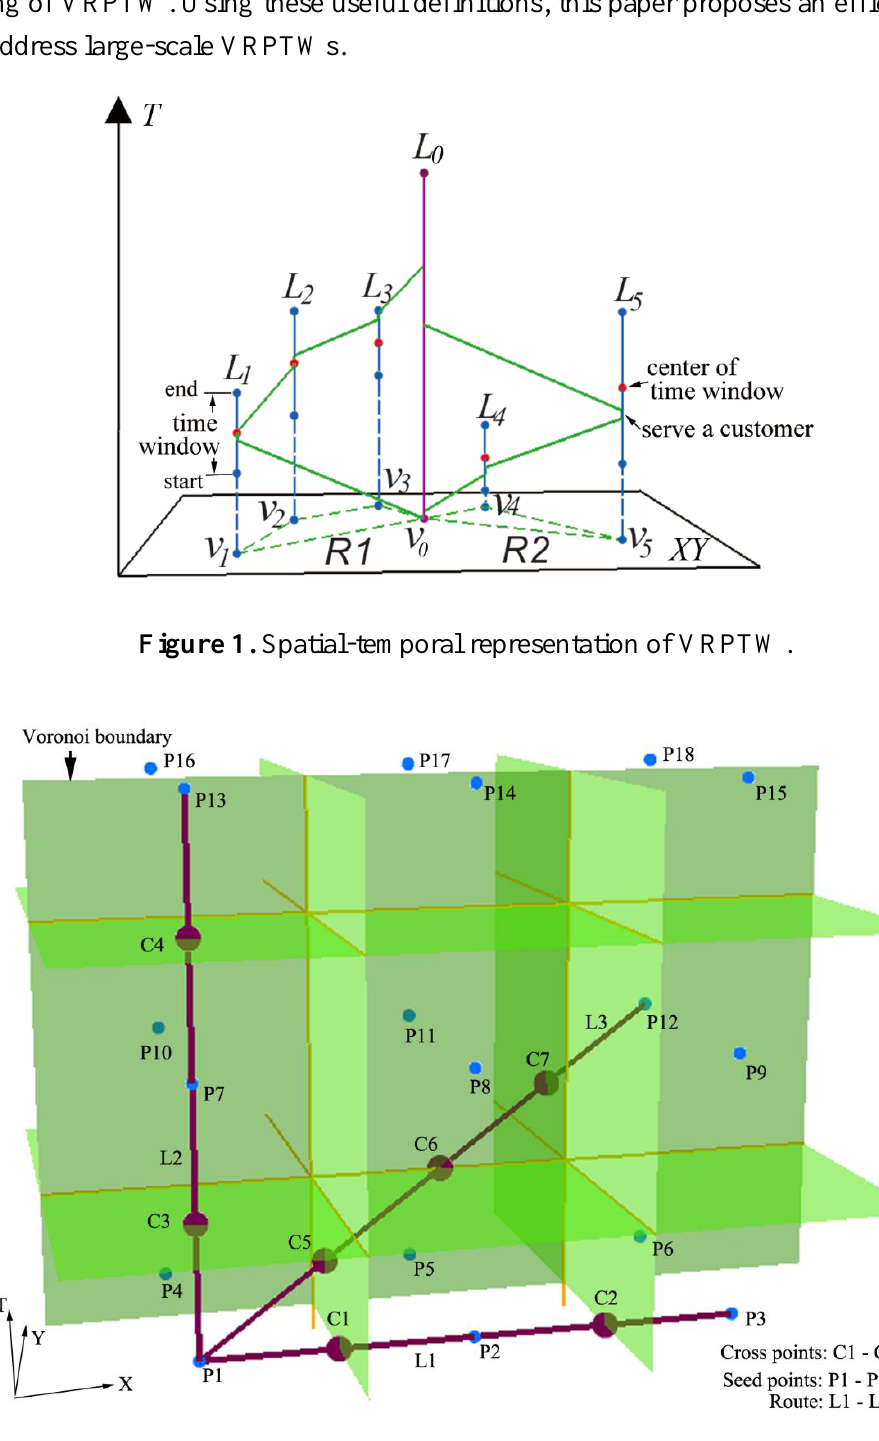
Figure 2. The spatial-temporal Voronoi diagram and the spatial-temporal Voronoi